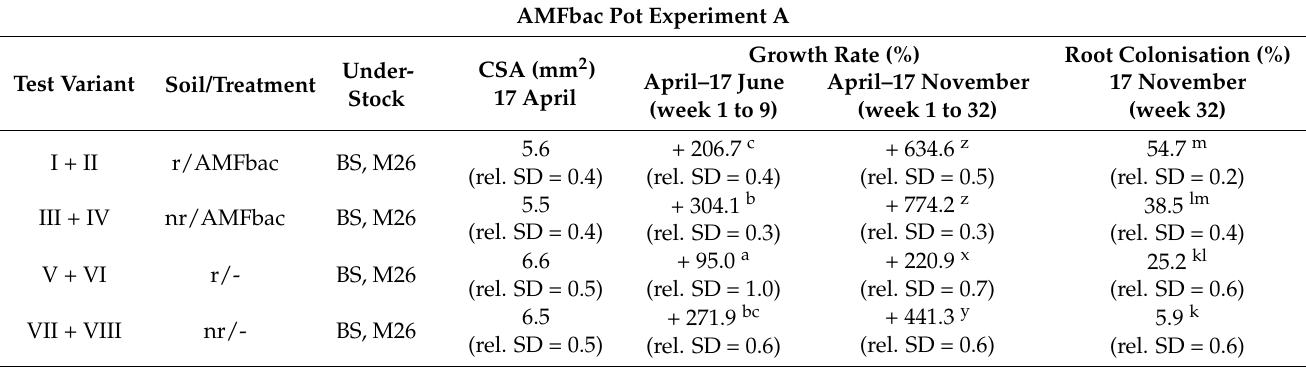
Table 9. AMFbac Pot Experiment A-Growth rate of CSA and degree of mycorrhizal root colonization. AMFbac Pot Experiment A